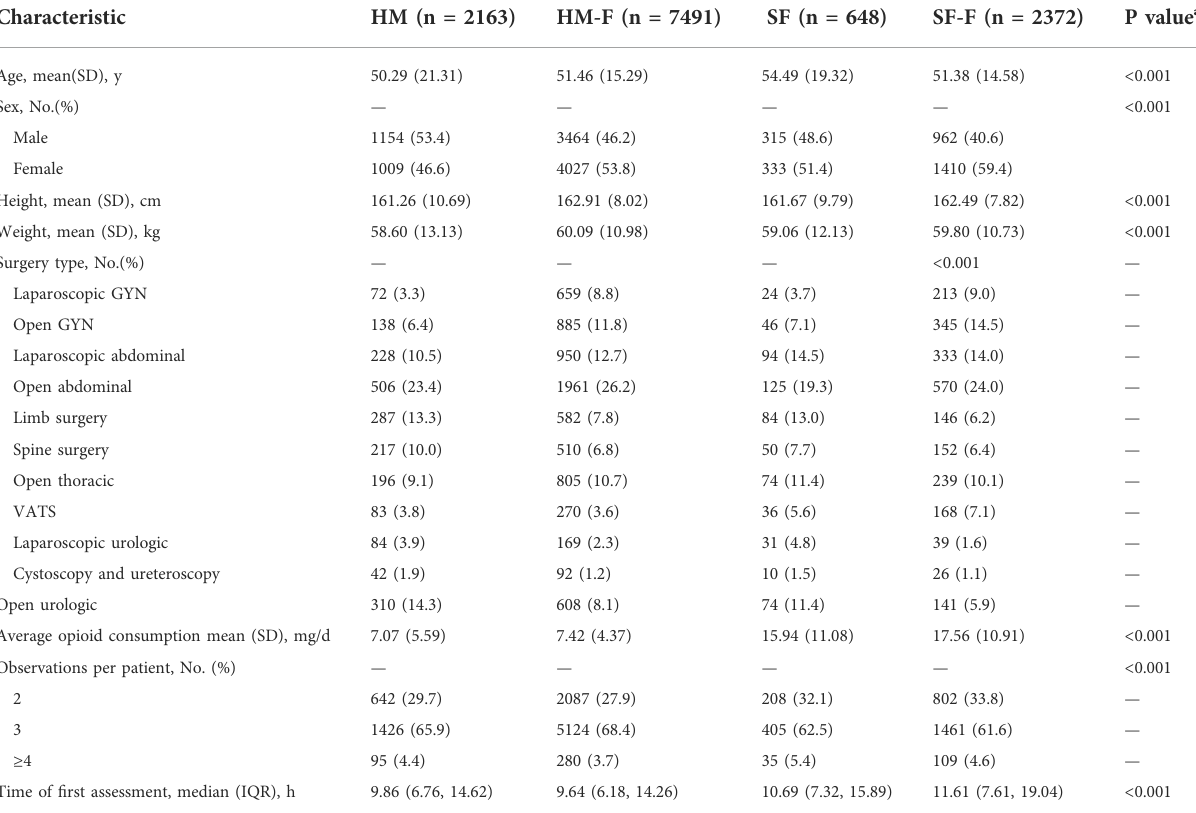
TABLE 1 Characteristics of the study